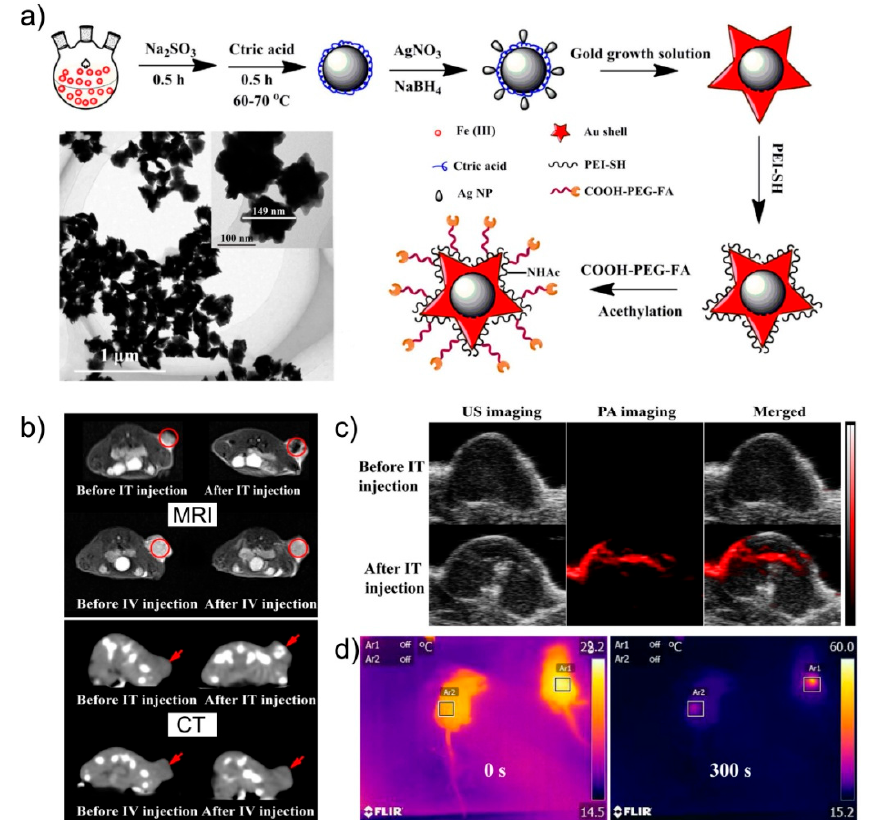
Figure 5. ( a ) Scheme of synthesis of Fe 3 O 4 @Au nanostars and corresponding TEM image. ( b ) In vivo MRI/CT imaging of a xenografted tumor model before and at 0.5 h post intratumor and at 6 h post intravenous injections of Fe 3 O 4 @Au NHS. ( c ) In vivo ultrasound/PA images of tumors before and at 0.5 h post intratumor injection of Fe 3 O 4 @Au nanostars. ( d ) Full-body photothermal images of mice